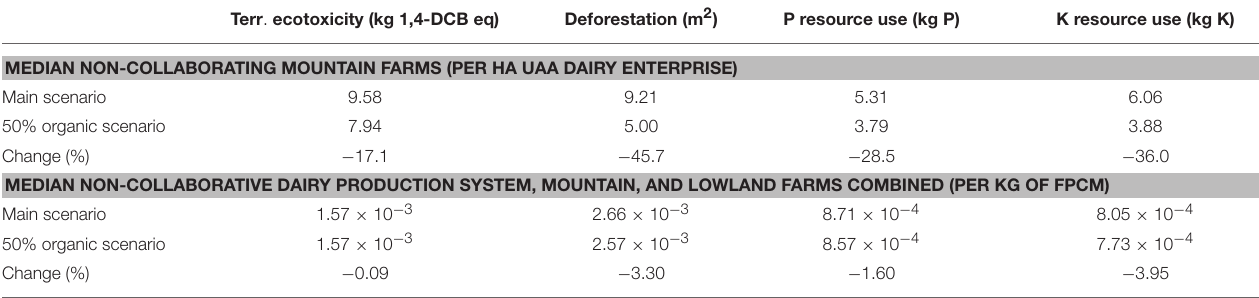
TABLE 2 | Sensitivity analysis: conversion of two non-collaborative mountain farms into organic farms (50% organic scenario) compared to the original scenario, in which all non-collaborative mountain farms were conventional farms (main scenario) for the impact categories affected the most by this change (terrestrial ecotoxicity, deforestation, P resource use, K resource